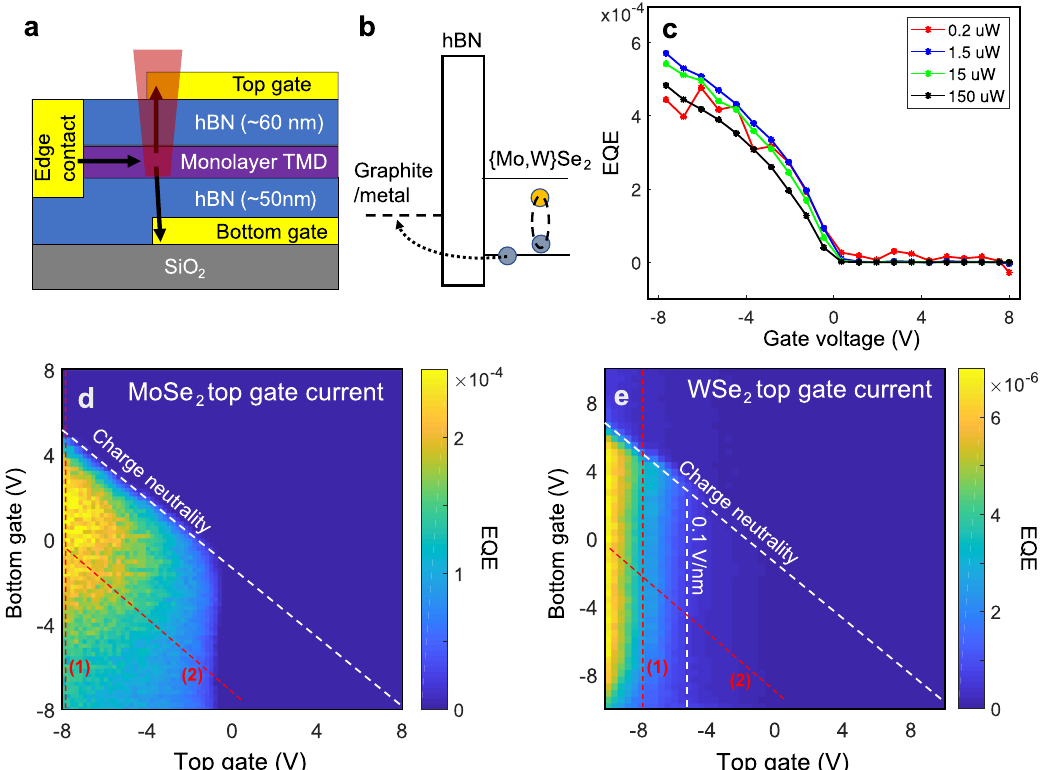
Figure 2: Power, field, and doping dependence in MoSe 2 and WSe 2 . a) Schematic of the dual-gated, hexagonal boron nitride (hBN) encapsulated transition metal dichalcogenide (TMD) structure designed